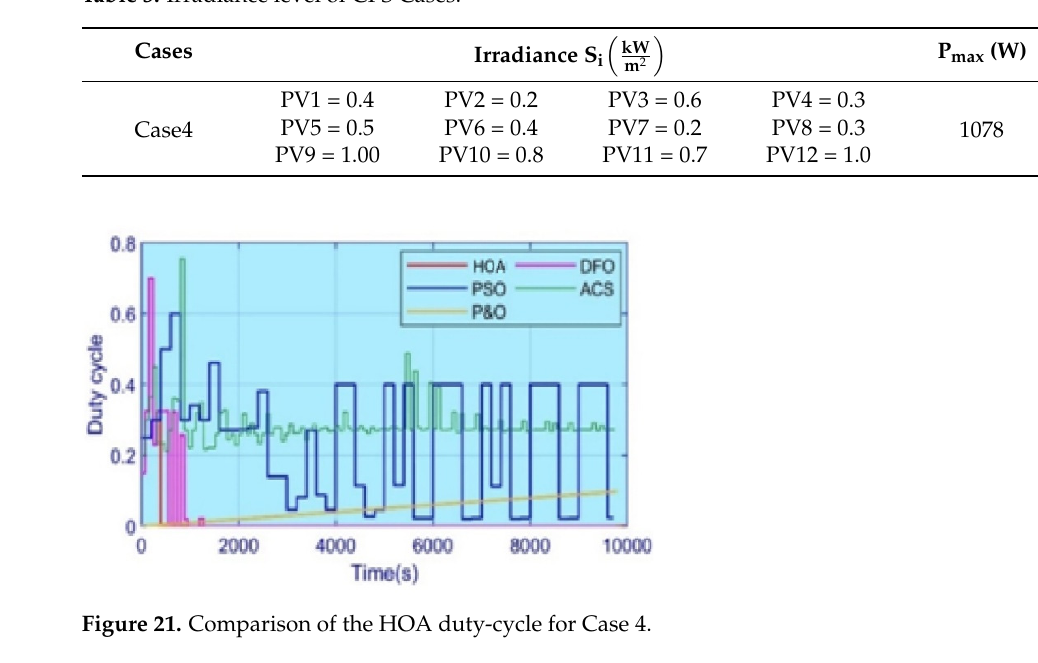
Figure 20. Comparison of the HOA voltage for Case 3 .